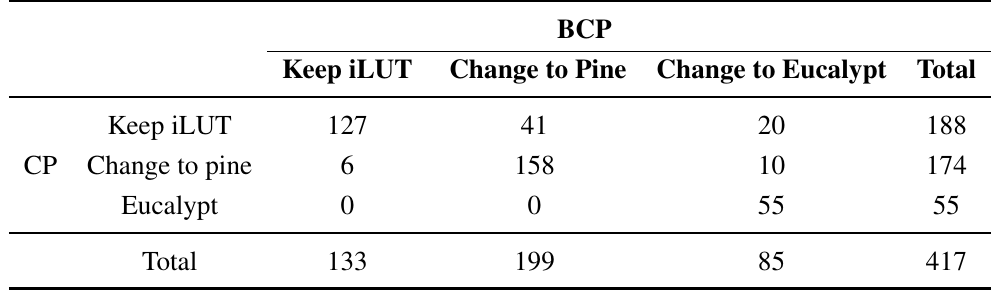
Table 6. Confusion matrix contrasting the output of Compromise Programming (CP) and Balanced Compromise Programming (BCP). Overall agreement =